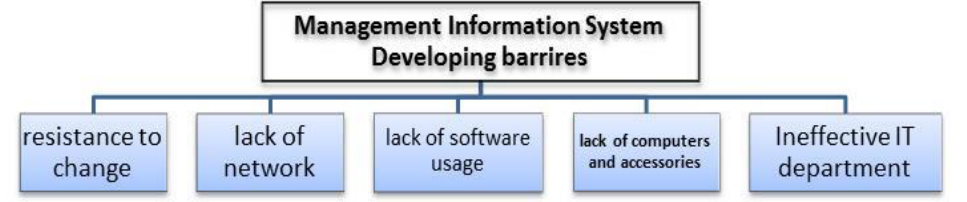
Fig. 19. Management information system developing